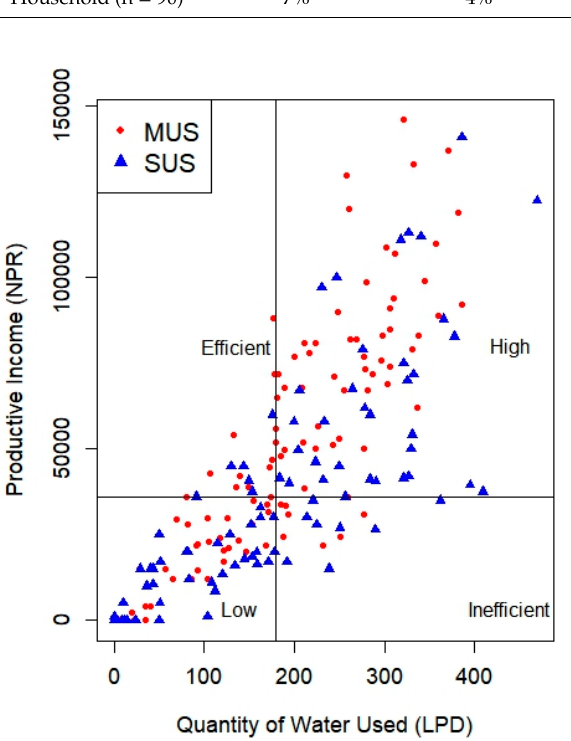
Figure 2. Household water consumption and productive Figure 2 : Household water consumption and productive income.